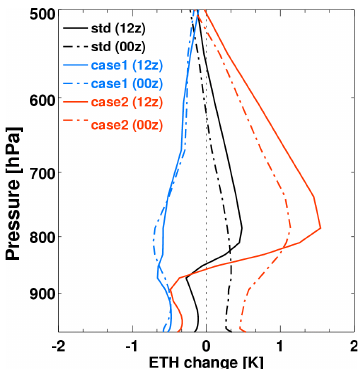
Figure 9 Dust impact on the atmospheric diabatic heating profiles at 00 UTC and 12 4 Fig. 9. Dust impact on the atmospheric diabatic heating profiles at UTC averaged over the WAM region (6 o N-17 o N and 15 o W-10 o E) from WRF-Chem 5 00:00UTC and 12:00UTC averaged over the WAM region (6 ◦ N– 17 ◦ N and 15 ◦ W–10 ◦ E) from WRF-Chem simulations in three simulations in three cases with different dust absorption properties: std (ni=0.003), case1 6 cases with different dust absorption properties: std ( n i =0.003), (ni=0.0004), and case2 (ni=0.006), where ‘ni’ represents the imaginary part of the 7 case1 ( n i =0.0004), and case2 ( n i =0.006), where “ n i ” represents refractive index of dust. 8 the imaginary part of the refractive index of dust.